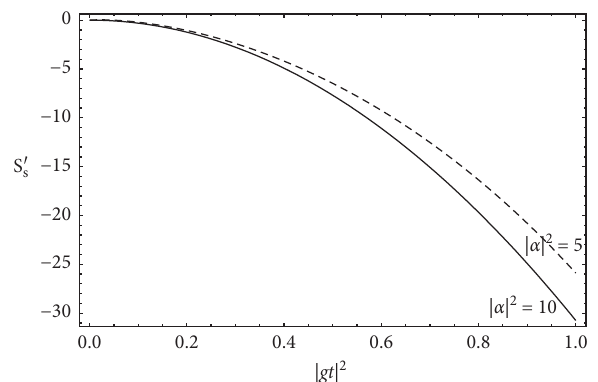
Figure 3: Variation of the sum squeezing S